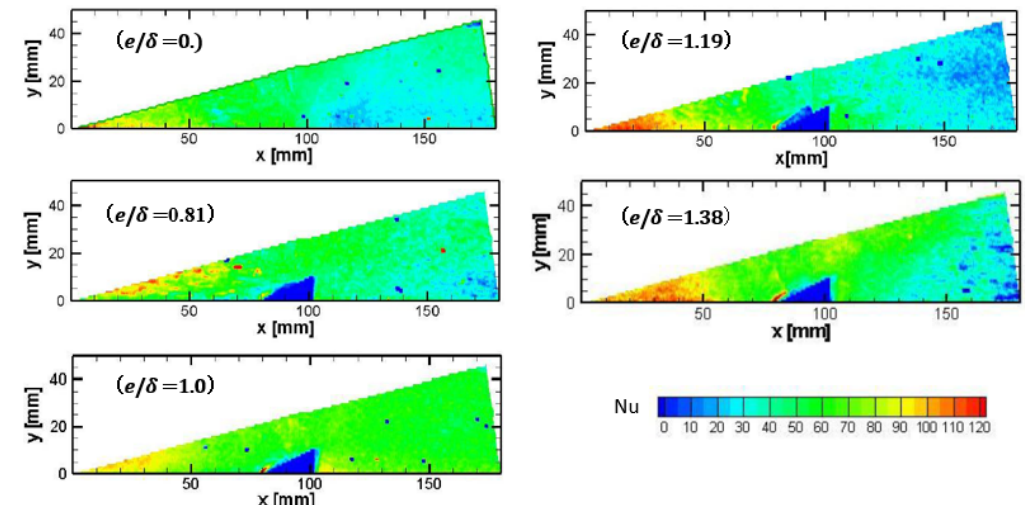
Figure 10. Effect of VG height on the Nu distribution (at the fixed VG location r / D = 2.5, Re D = 10,000).